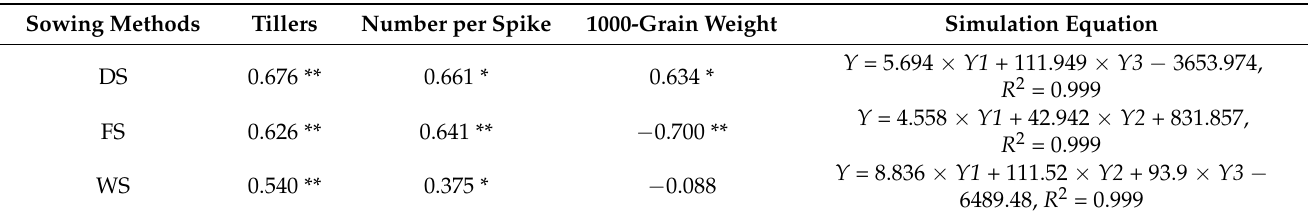
Table 3. Correlation between yield and